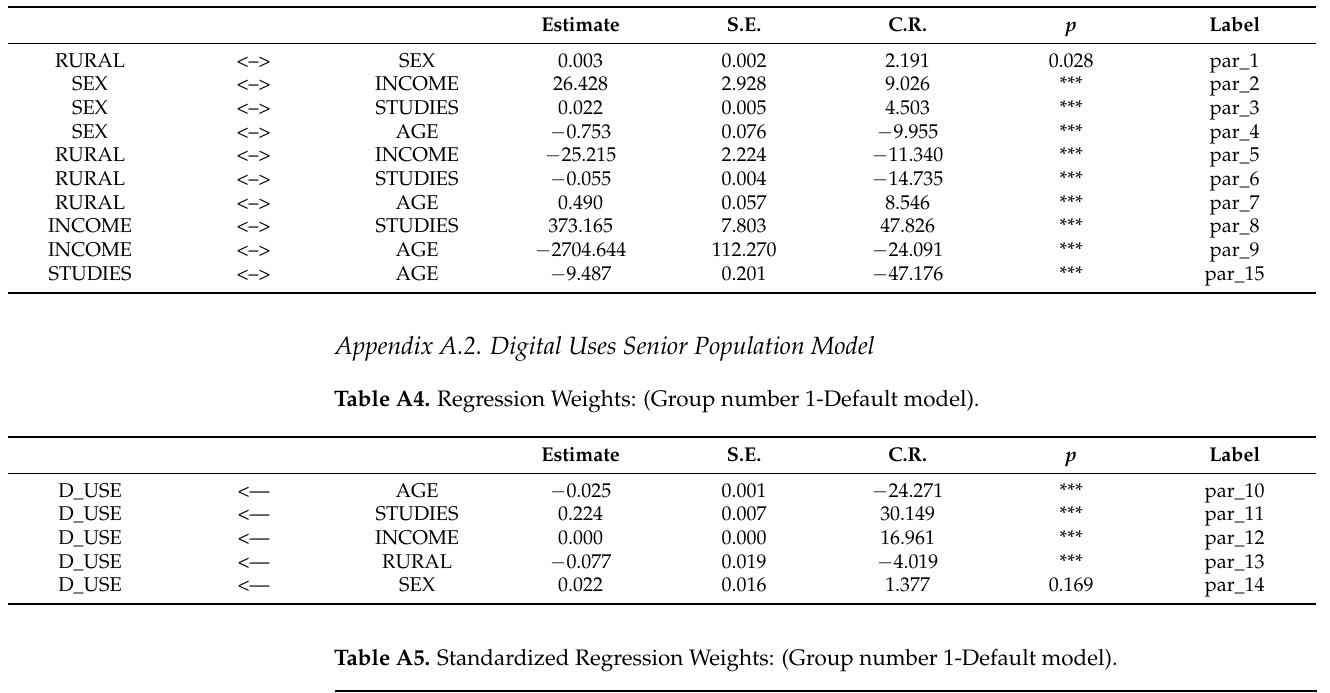
Table A3. Covariances: (Group number 1-Default model).